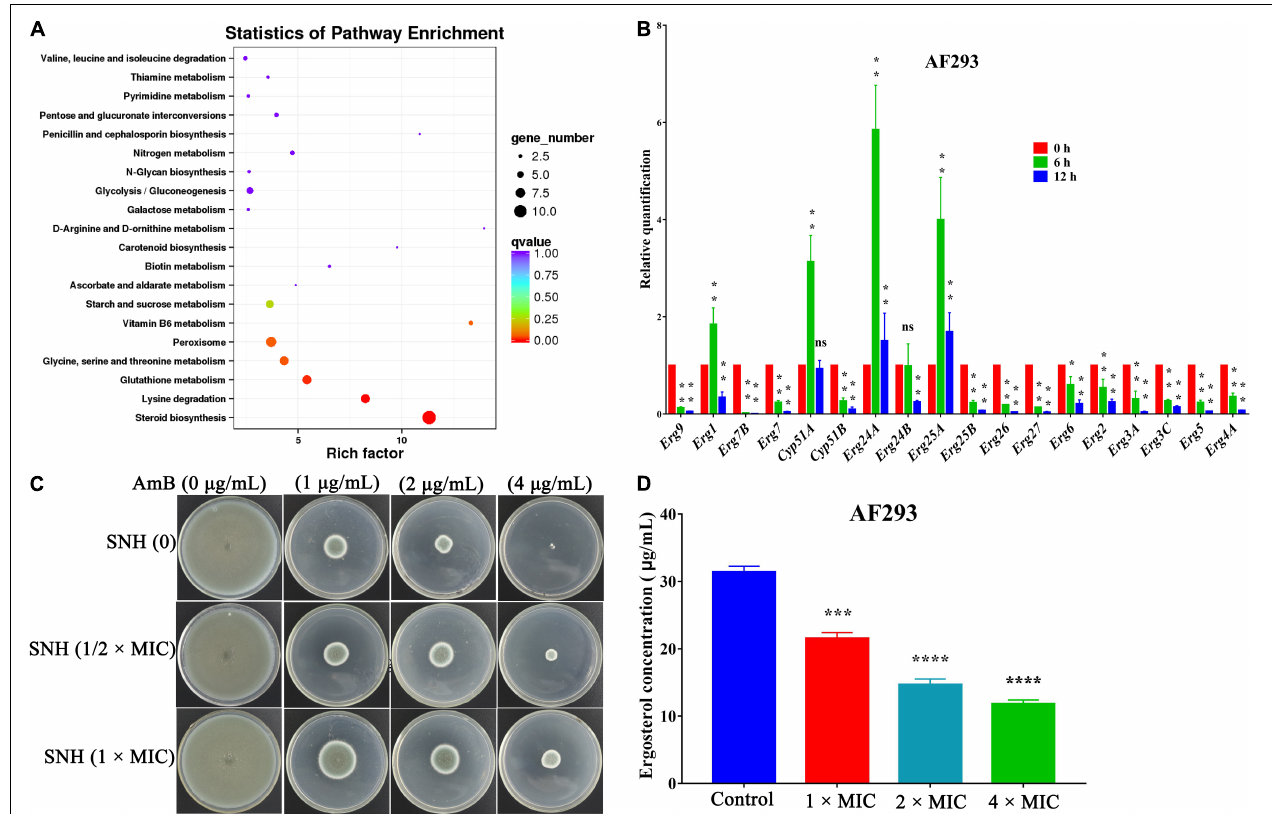
FIGURE 5 | Antifungal mechanism of sodium new houttuyfonate (SNH). (A) Scatter plot of KEGG pathway enrichment statistics for the top 20 enriched pathways. The enrichment factor is the ratio of the number of genes that were differentially expressed to the total number of genes in a certain pathway. The color and size of the dots represent the range of the q-value and the number of DEGs mapped to the indicated pathways, respectively. (B) qRT-PCR analysis of gene expression levels. AF293 was incubated in the absence (control) or presence (2 × MIC) of SNH in RPMI-1640 medium at 37 ◦ C for 6 and 12 h. The histogram shows the relative expression of genes after SNH treatment with respect to the control. (C) A. fumigatus treated with SNH showed significantly diminished sensitivity to the AmB drug. AF293 conidia were treated with 0, 1/2 × , and 1 × MIC SNH for 12 h at 37 ◦ C, then inoculated on PDA solid medium supplemented with AmB (0, 1, 2, and 4 µ g/mL). (D) Quantification of ergosterol content. AF293 conidia were grown for 3 days in RPMI-1640 medium containing 0, 1 × , 2 × , and 4 × MIC SNH; ergosterol was extracted with 100% methanol; and spectral profiles were determined at 280 nm. Results represent the average of three independent experiments ± SD. The level of statistical significance was set at * P < 0.05. ** P < 0.01, *** P < 0.001, and **** P < 0.0001; ns indicates no statistical